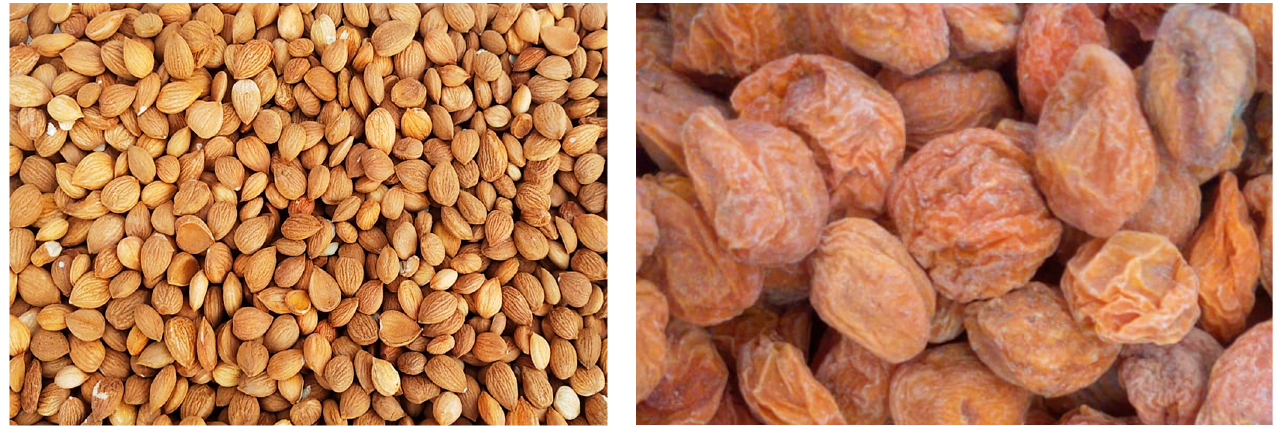
Figure 1. Apricot kernel seed and fruit identification. Table 1. Different chemical and nutritional components present in the apricot